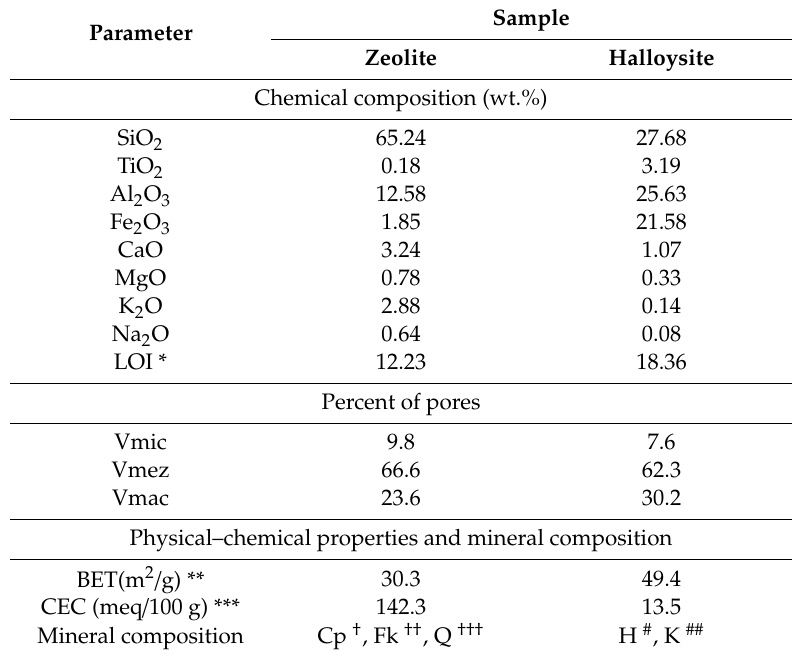
Table 2. Chemical, physical, and mineralogical characteristics of the sample